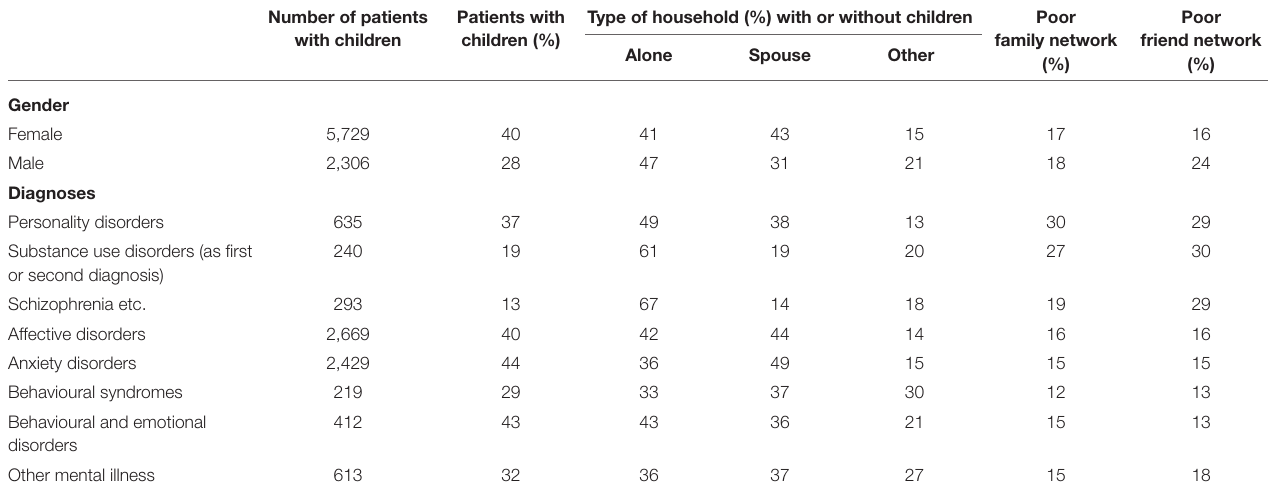
TABLE 2 | Gender, diagnosis and prevalence of outpatients ( N = 8,035) with care for children under 18 among sociodemographic subgroups.